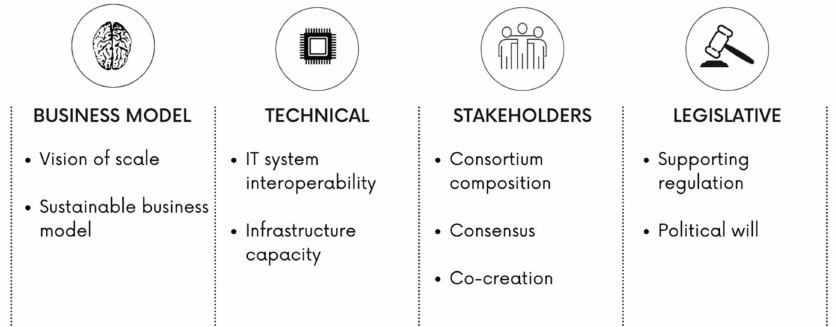
Figure 4. Key factors identified in the empirical